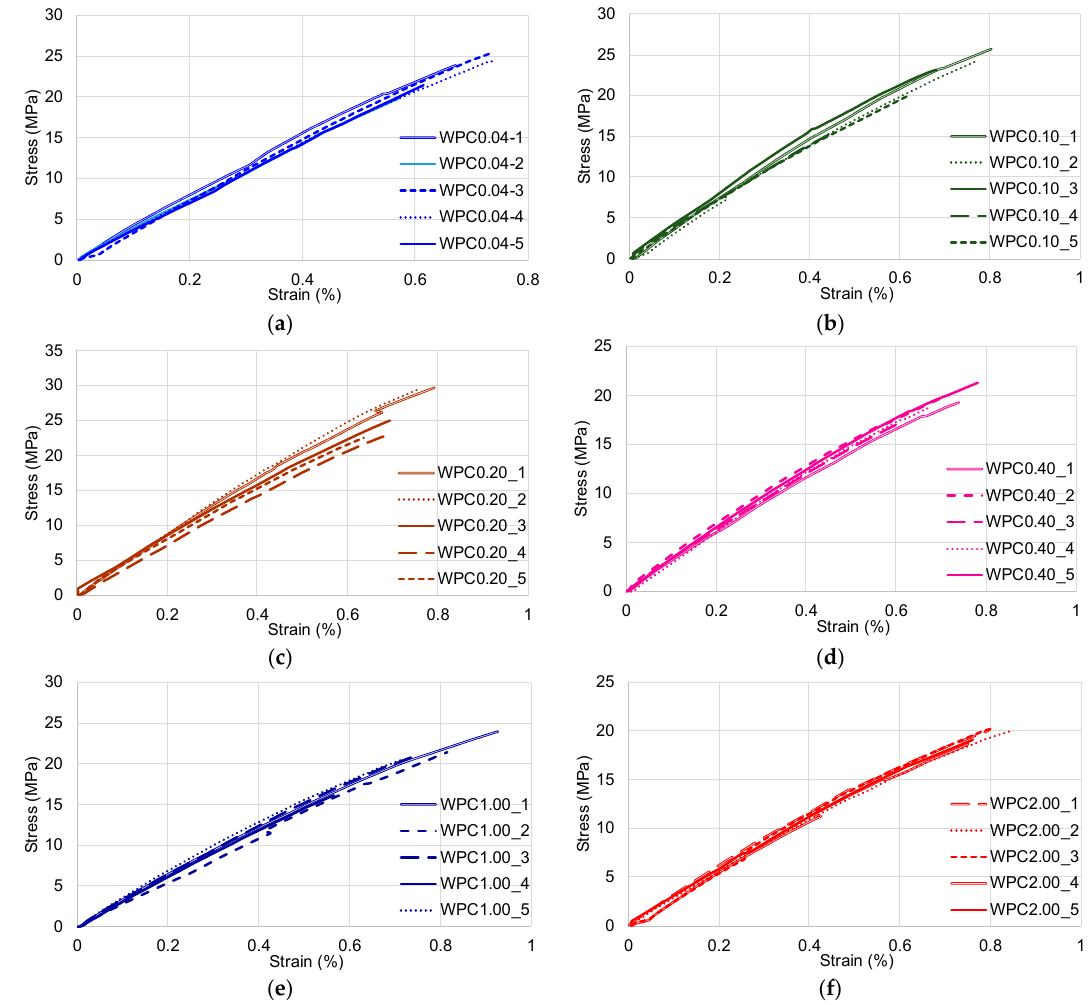
Figure 5. Characteristic curve stress–strain of wood particle reinforced composites: ( a ) stress–strain characteristic curves of WPC0.04 specimens; ( b ) stress–strain characteristic curves of WPC0.10 specimens; ( c ) stress–strain characteristic curves of WPC0.20 specimens; ( d ) stress–strain characteristic curves of WPC0.40 specimens; ( e ) stress–strain characteristic curves of WPC1.00 specimens; ( f ) stress–strain characteristic curves of WPC2.00 specimens.